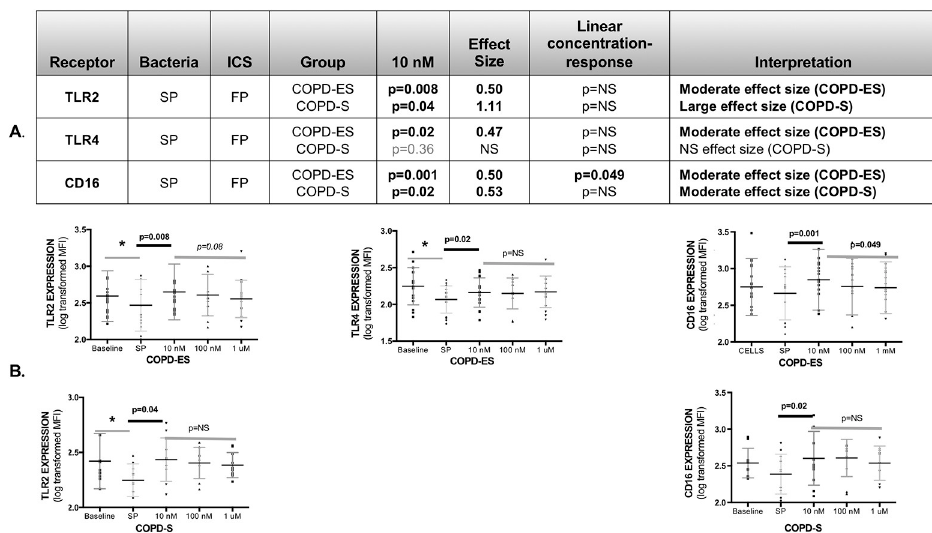
Fig 4. Fluticasone propionate increased bacterial recognition receptor expression on MDMs from subjects with COPD for SP only, with greatest receptor upregulation at 10 nM, reflecting an inverse concentration-response relationship. Analysis of log-transformed data on receptor MFI (mean fluorescence intensity). The p-values were calculated by paired T-test, assessing the effect of fluticasone propionate (FP) at 10 nM on SP-induced reduction of receptor expression on MDMs from COPD ex-smokers (COPD-ES) and COPD current smokers (COPD-S). Effect size for FP effect on MDM receptor expression at 10 nM was calculated by Cohen’s-d calculation (A, Table) . Only CD16 demonstrated a significant concentration–response relationship (inverse) to FP. Receptor expression is presented as an aligned dot-plot with thin black bar at the mean, flanking short grey bars delineating the SD (B, Figures) . Significant p-values for fluticasone effect on receptor expression at 10 nM are noted above the thick short black bars. Linear trend analysis (denoted by thick dark grey line) was done for concentration-response relationship between 10 nM, 100 nM and 1 μ M of FP calculated by repeated measures one-way ANOVA. Significant reductions in baseline receptor expression by SP are noted by an asterisk ( � ), representing significant data presented in